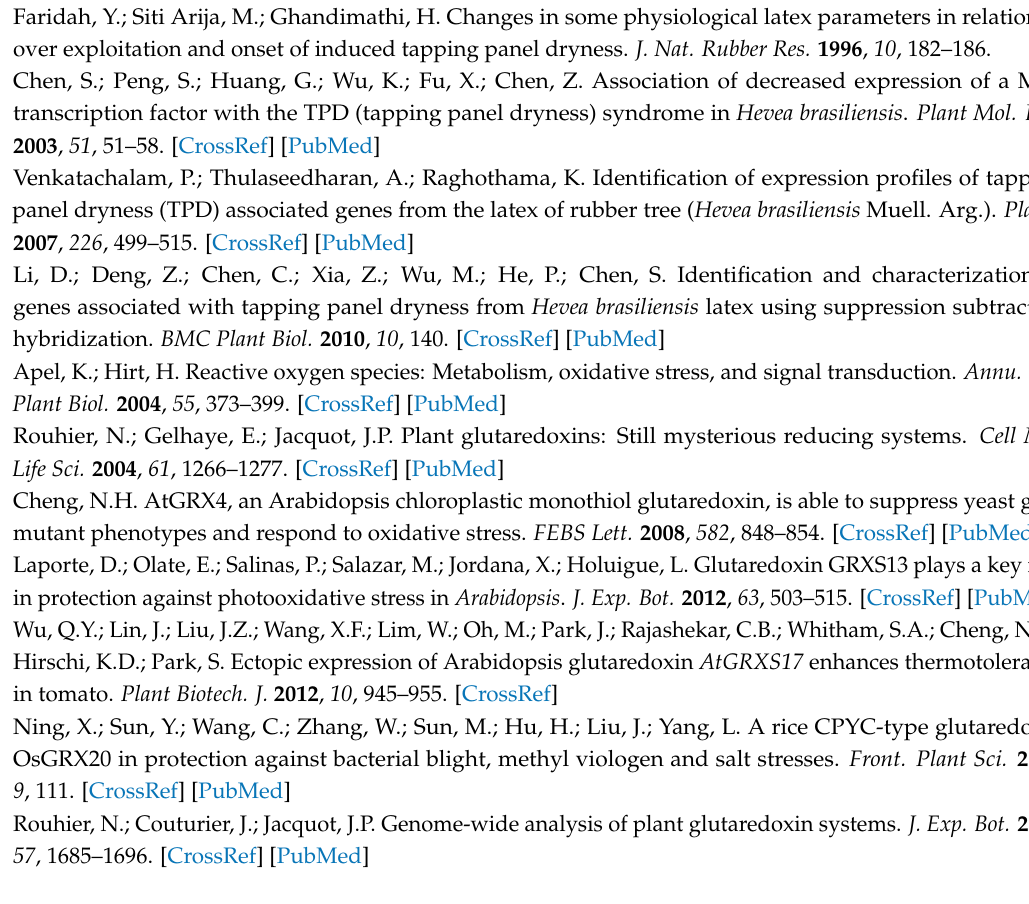
Figure S1: Rubber trees from different TPD